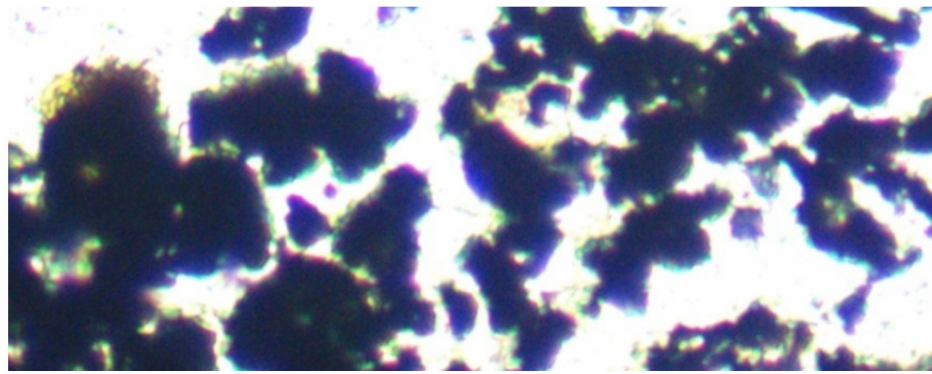
Figure 3. Fe 0 particles. Transmitted light, field of view = 0.1 mm (100 microns).